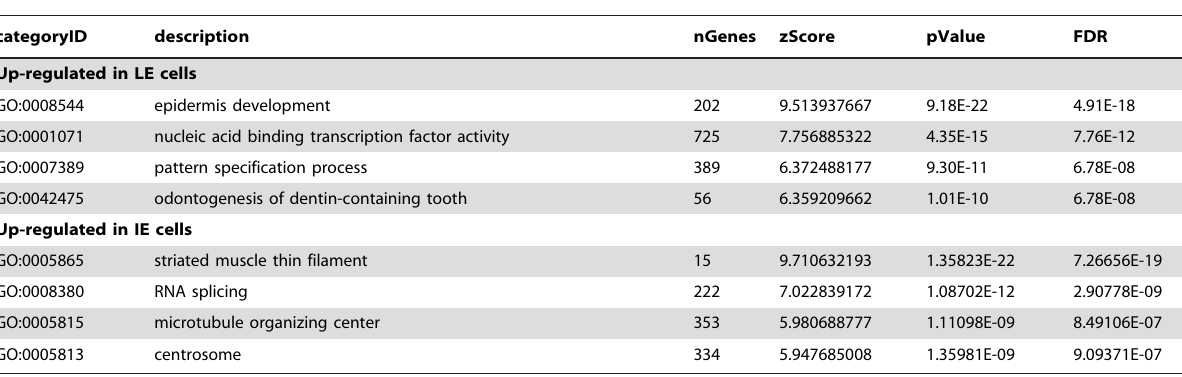
Table 1. Gene Functions in LE and IE Cells.